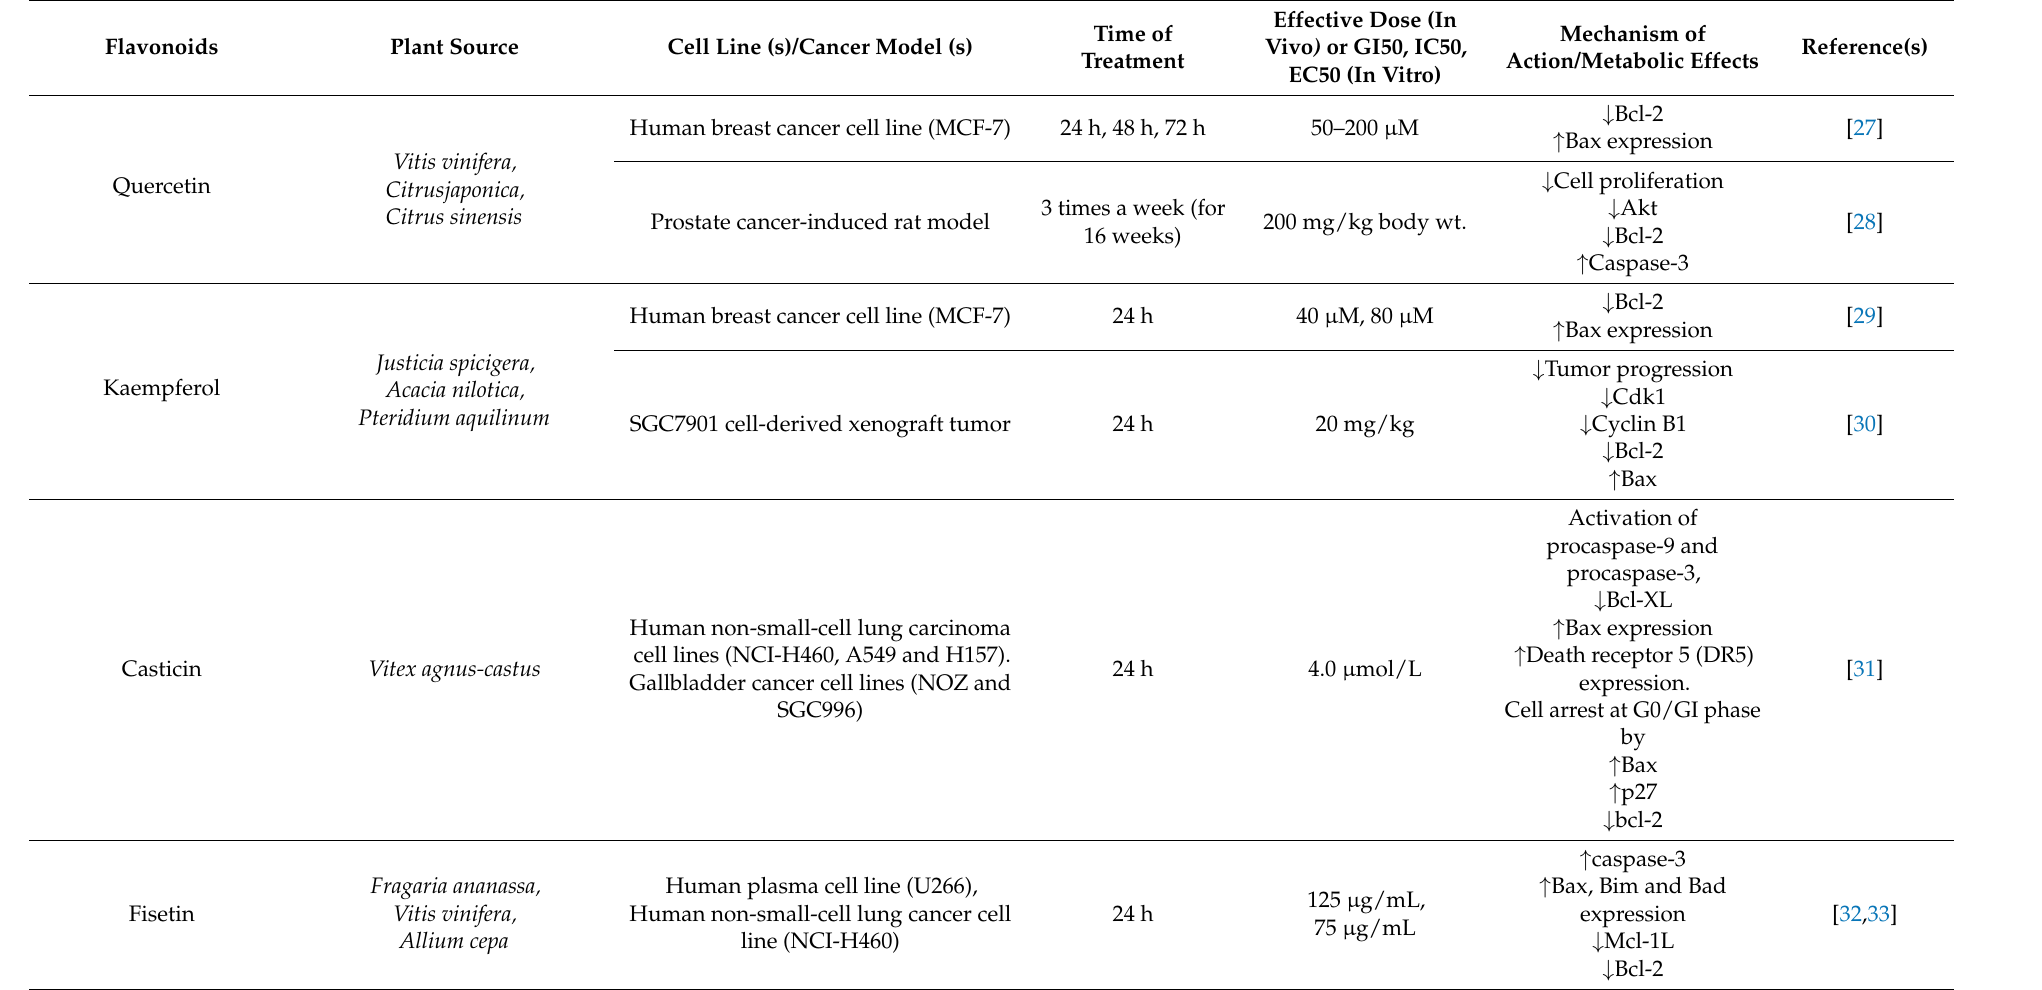
Table 1. The in vitro and in vivo activities of flavonoids in different cancer cell lines and their mechanism of